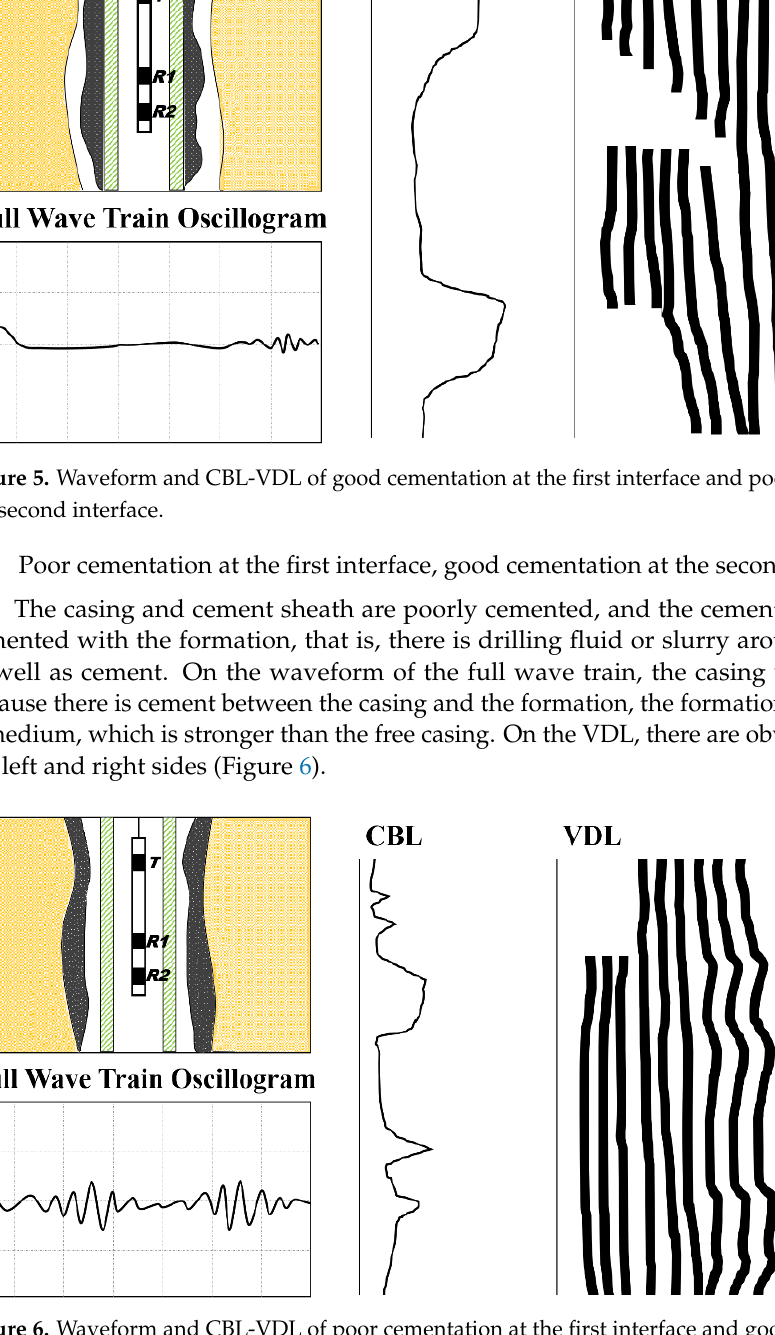
Figure 4. Waveform and CBL-VDL under good cementation of the first and second interface.